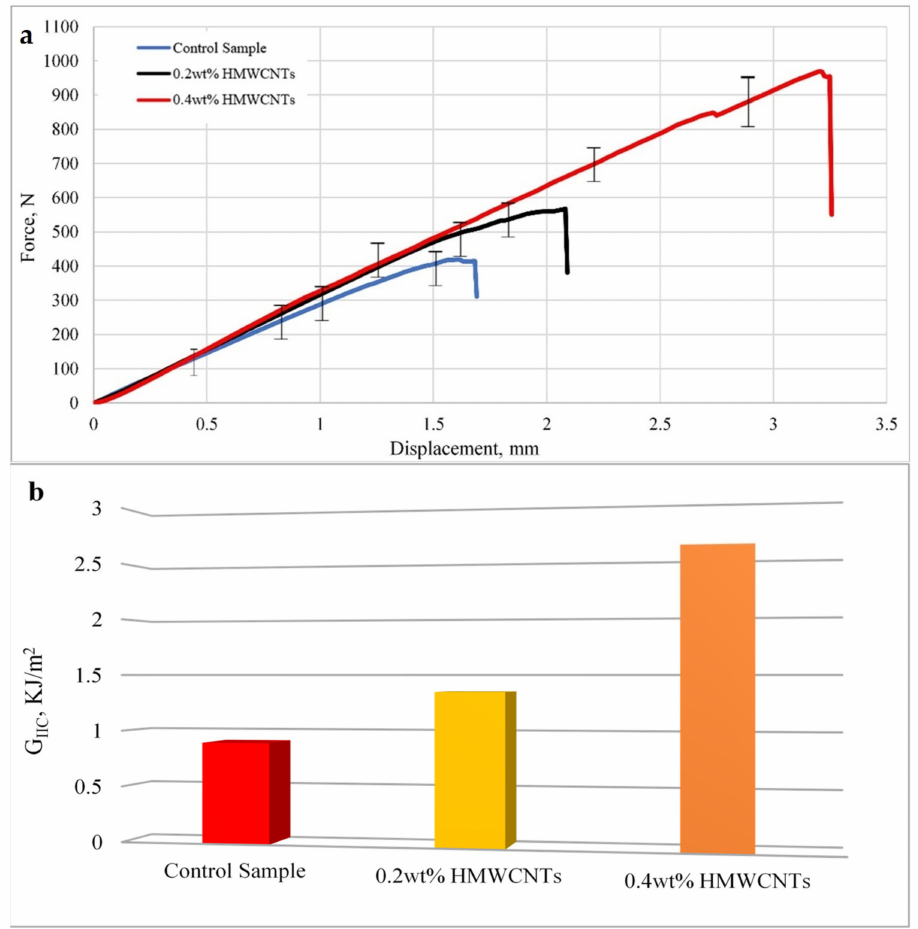
Figure 8. Mode II interlaminar fracture toughness results of the ENF test ( a ) Average load versus displacement curve; ( b ) G IIC values of control, 0.2 wt.%, and 0.4 wt.% HMWCNT composite